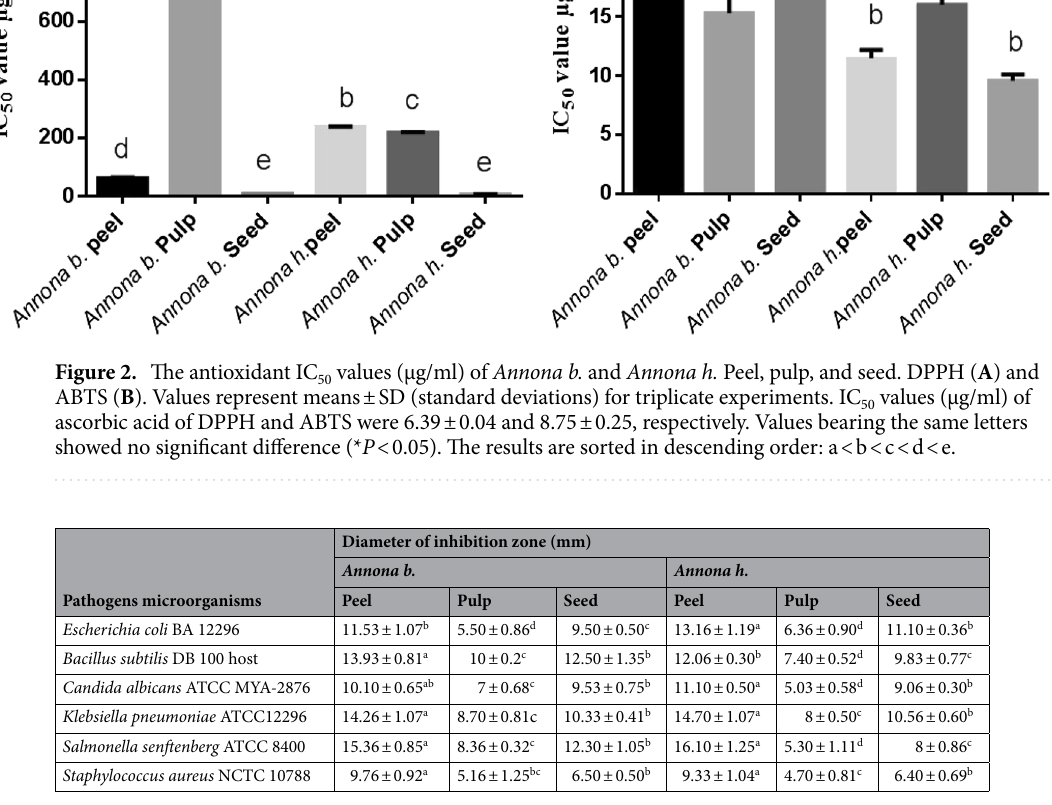
Table 2. Antimicrobial activity of peel, seed, and pulp extracts of Annona b. and Annona h.